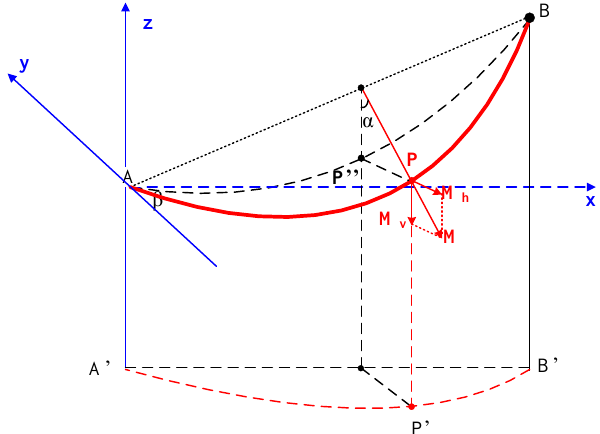
Figure 3. The diagrammatic sketch of the line under wind condition Curve APB is the state when the line is swinging, the dotted line AP''B is the projection of APB in the vertical plane (xoz plane), which can be approximated as the static state curve of the line, and A'P'B' is the projection of the line APB on the horizontal plane. If setting it as a parabolic contour, α is the horizontal dip (also called the yaw angle), based on force